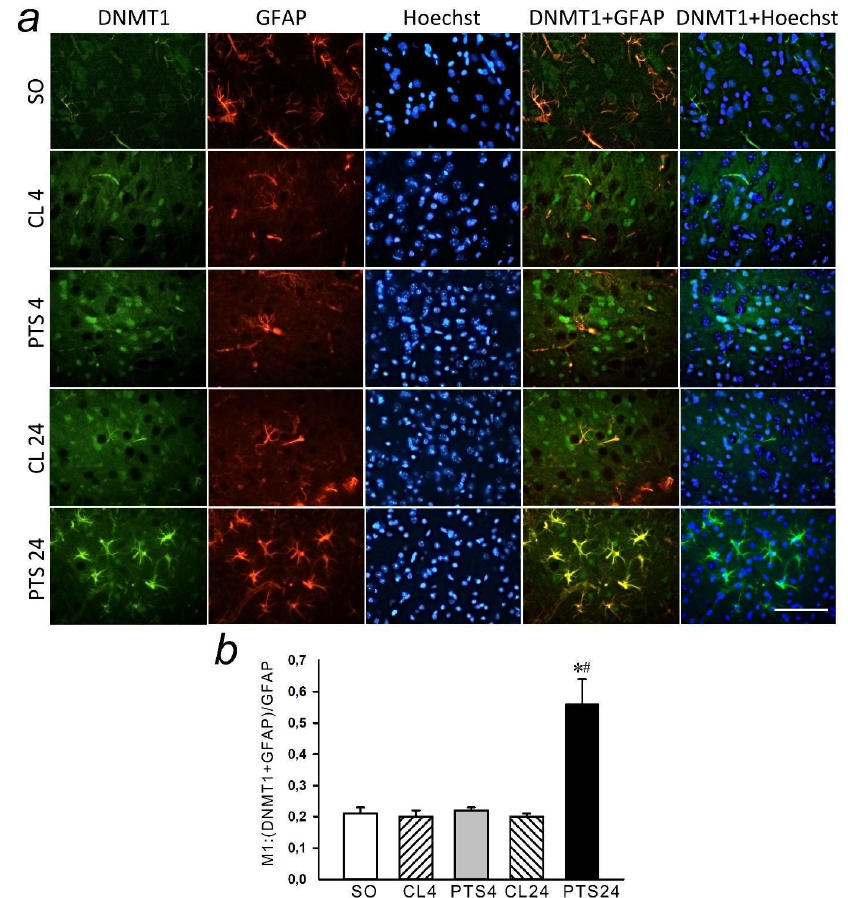
Figure 3. The changes of DNMT1 levels in the astrocytes of ischemic penumbra at 4 and 24 h after photothrombotic stroke (PTS) in the rat cerebral cortex. The levels of DNMT1 at 4 and 24 h after PTS are shown (PTS4 and PTS24, respectively) compared to the contralateral cortex of the same animals (CL4 and CL24), or the cortex of sham-operated rats (SO). ( a ) Immunofluorescence of DNMT1 (green), marker of astrocytes GFAP (red), nuclear chromatin marker Hoechst 33342 (blue), and image overlay. The scale bar is 50 μ m. ( b ) Coefficient M1 of DNMT1 co-localization with astrocyte marker (GFAP) in different control and experimental groups. * p < 0.05 compared to SO, # p < 0.05 compared to CL4 and CL24. One Way ANOVA; M ± SEM; n = 7.